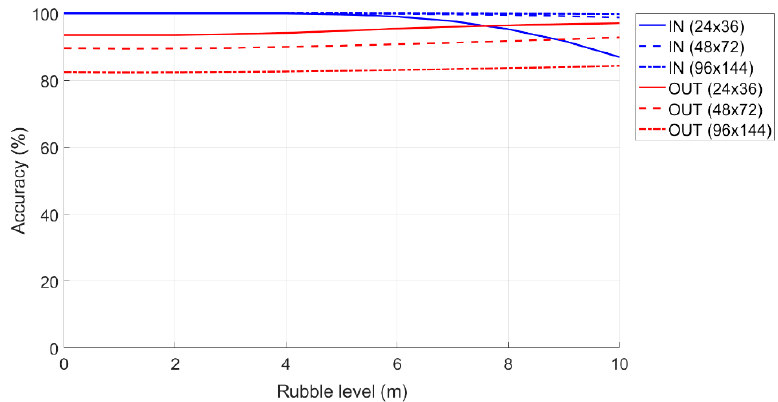
Figure 20. Accuracy in the classification of IN and OUT terminals as the amount of rubble increased and the femtocell was at a height of one meter from the ground.